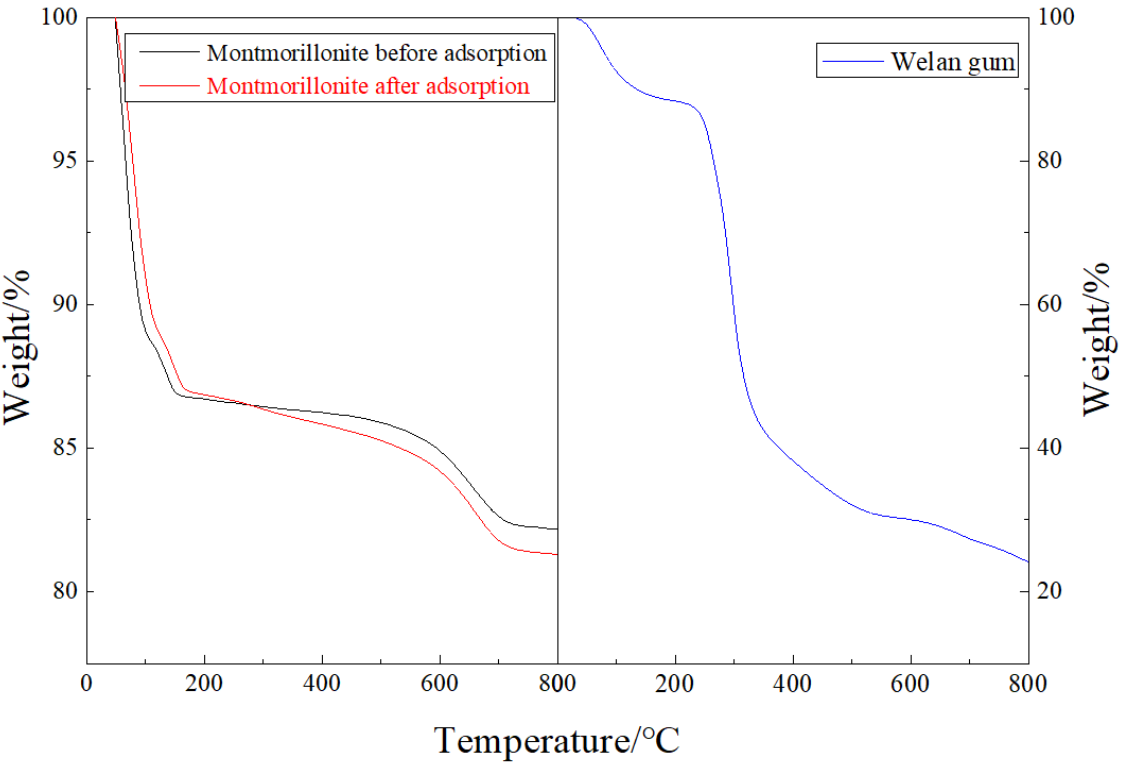
Figure 9. Thermalgravimetric curves of welan gum and montmorillonite before and after welan gum adsorption.